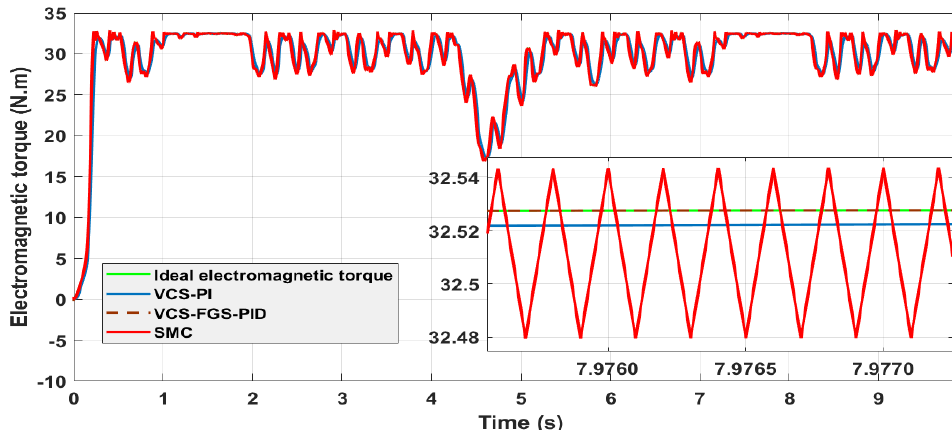
Figure 31. Electromagnetic torque.